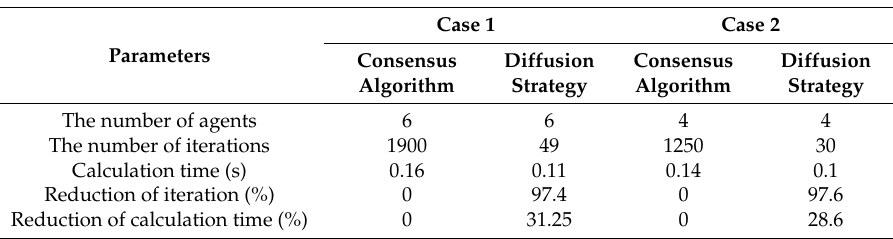
Table 2. The comparison for applying consensus algorithm and diffusion